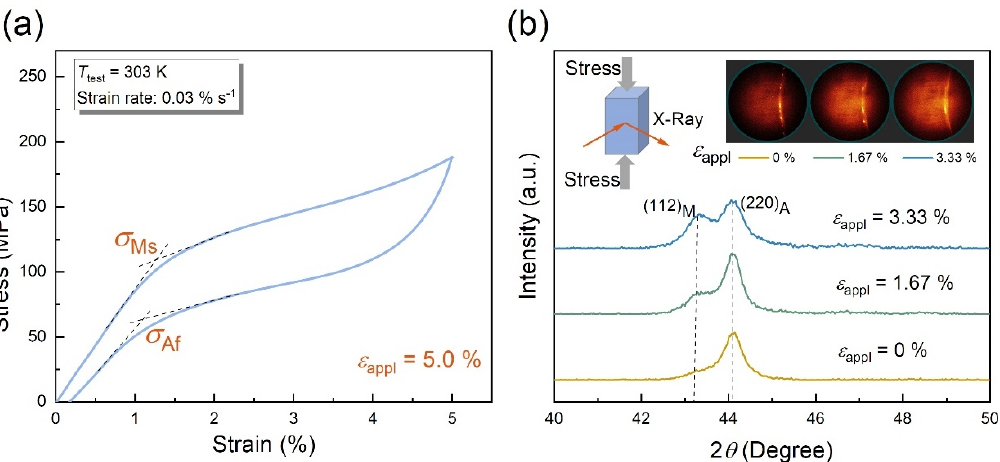
Figure 2. ( a ) The isothermal compressive stress–strain curve for the textured Co 51.6 V 31.4 Ga 17 alloy at room temperature (the strain rate is 0.03% s − 1 ). ( b ) XRD patterns of the textured alloy under uniaxial stress at room temperature.